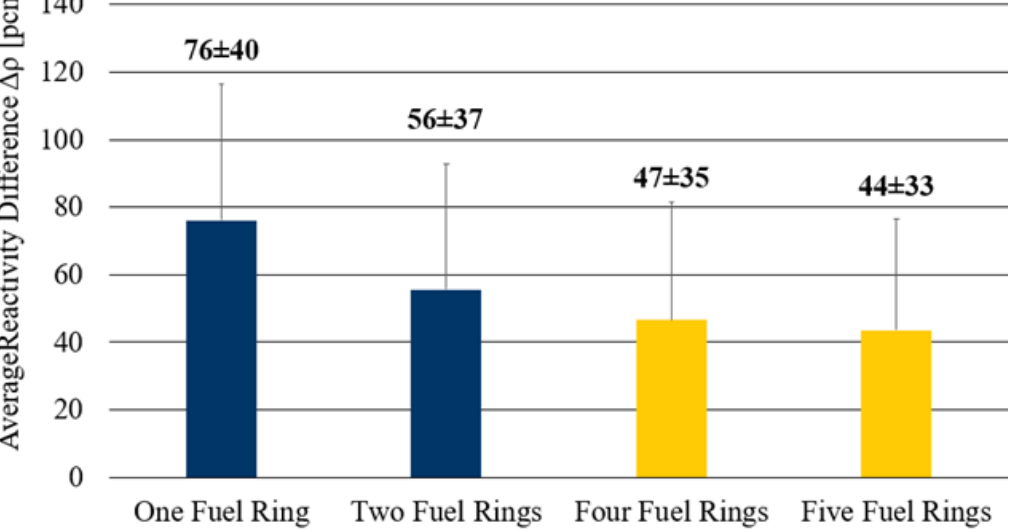
Figure 12. Average difference from McCARD k inf and standard deviation for single pin spatial mesh